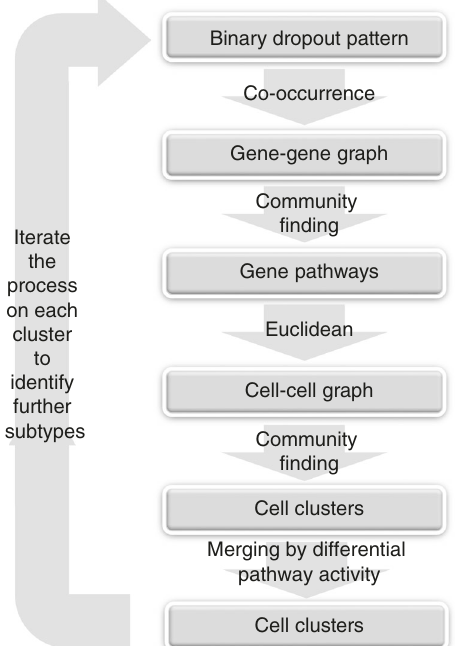
Fig. 1 Flowchart of co-occurrence clustering. The co-occurrence clustering algorithm is a divisive hierarchical process that iteratively identi fi es gene pathways based on binary dropout patterns and cell clusters based on the gene